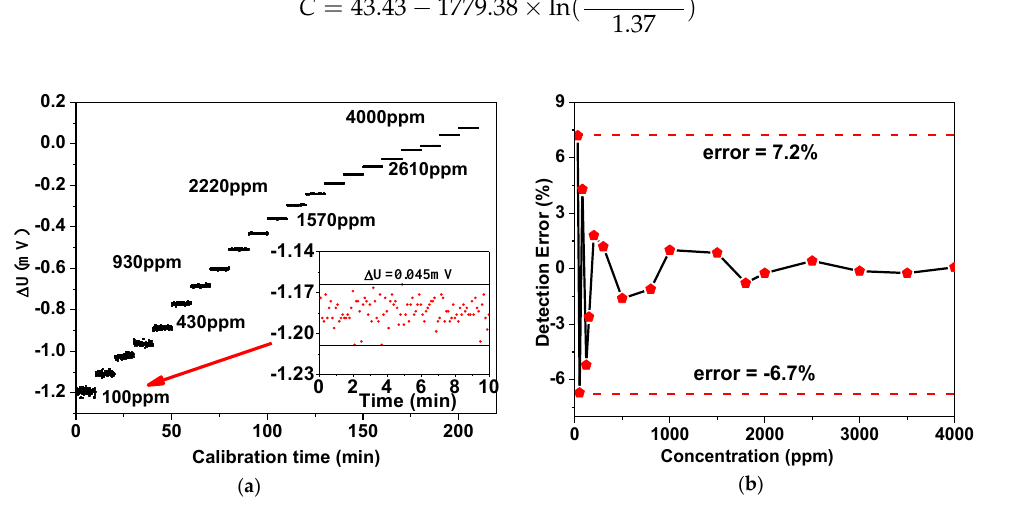
Figure 5. ( a ) Experimental data dots of the differential voltage (Δ U ) versus the standard CO 2 concentration. The inset shows the measured Δ U under 100 ppm for 10 min; ( b ) The measured detection errors for the prepared samples with the calibrated CO 2 sensor.